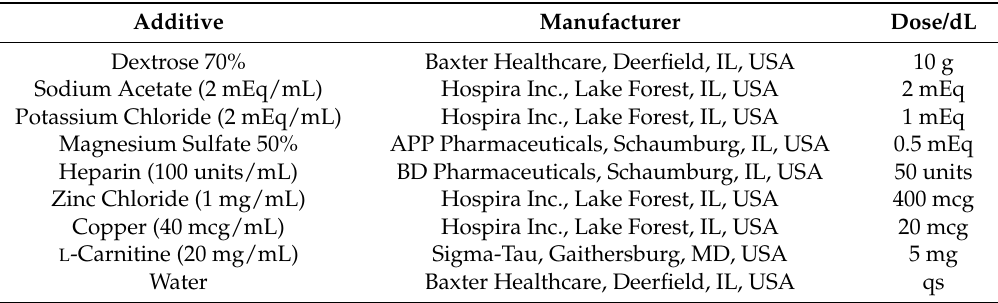
Table 1. Additives included in all study